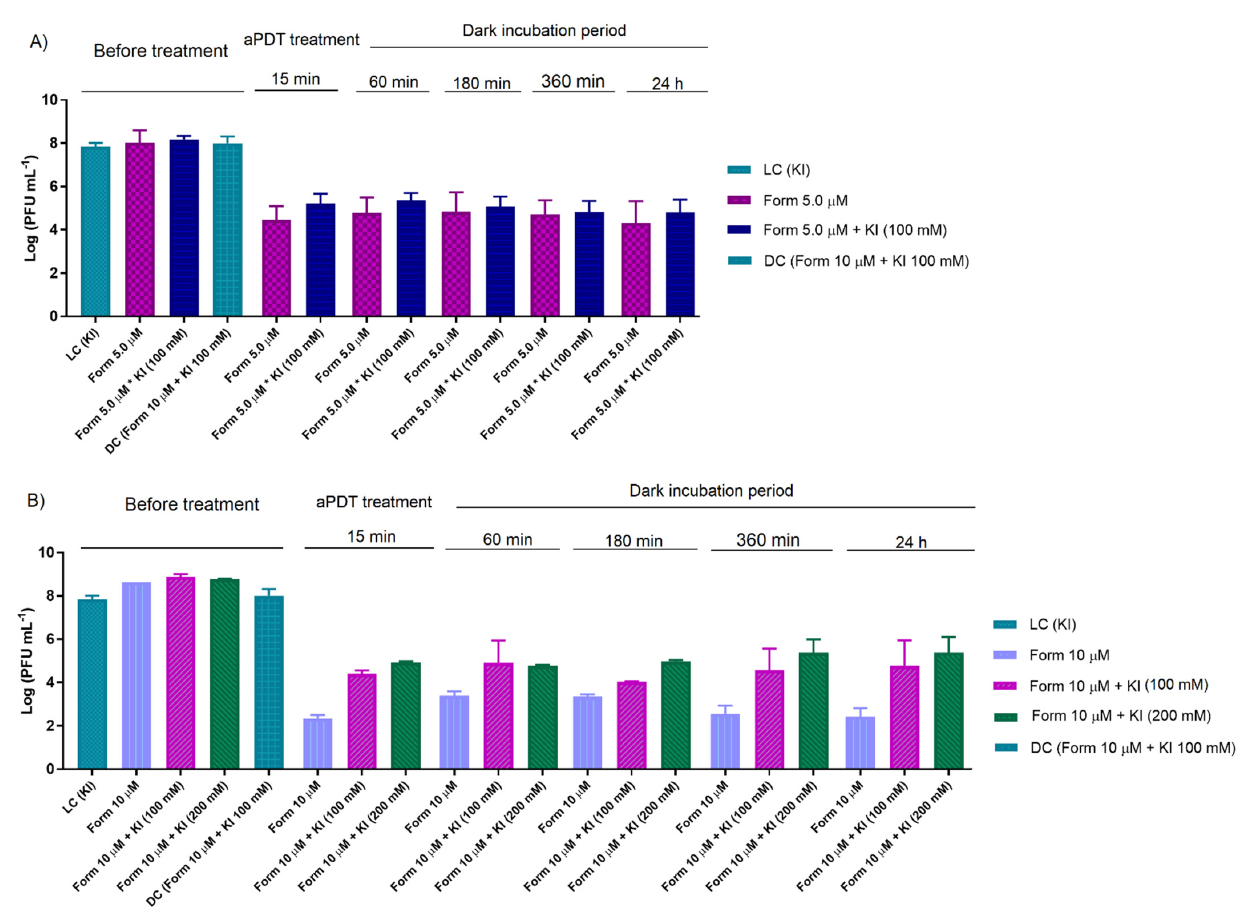
Figure 4. Effect of residual iodine species in dark incubation after aPDT assay in T4-like bacteriophage in non-filtered WW with Form at 5.0 and KI at 100 mM ( A ), and 10 µM and KI at 100 and 200 mM ( B ), during 15 min of irradiation with white light (50 mW cm − 2 ). The values are expressed as the mean of three independent experiments; error bars represent the standard deviation (SD) between the experiments. In some cases, SD bars are covered behind the bars.